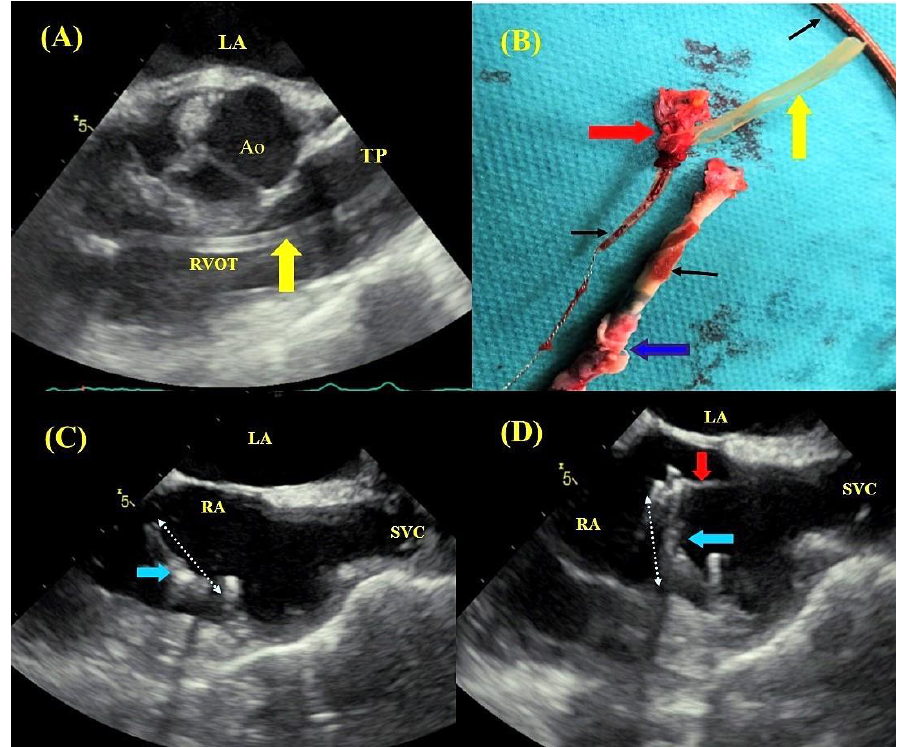
Figure 6. Remnants in heart chambers after TLE. TEE images—mid-esophageal view, transaortic view—fragment of silicone insulation (yellow arrow) stripped o ff the lead during TLE, dislodged into the right ventricular outflow tract (RVOT) and the pulmonary trunk (TP) ( A ). TEE images of the extracted ventricular lead (black arrows): unchanged fragment, lead tip with elongated guide wire, a fragment of endocardial tissue (red arrow) and silicone insulation (yellow arrow), segment of the lead surrounded by a fibrous capsule (blue arrow) and endocardial tissue (the image confirming lead adhesion to cardiac tissues) ( B ). TEE images—mid-esophageal bicaval view—fragment of a thickened (hyperechogenic) atrial lead adhering to the atrial wall, fractured during TLE (white and blue arrows) ( C ). The free-floating tip was captured by a lasso catheter (red arrow) ( D